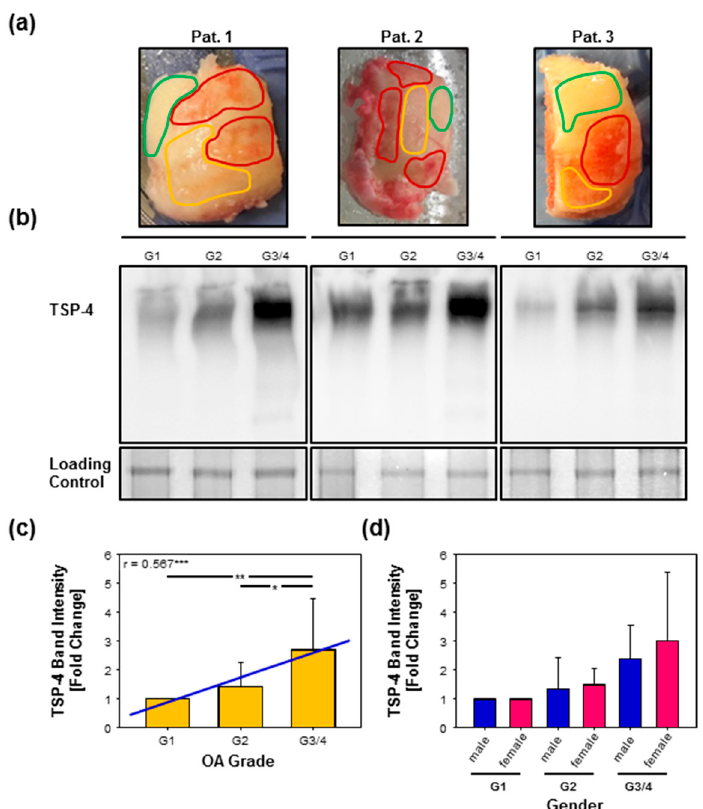
Figure 2. Detection of TSP-4 in total protein extracts from OA knee articular cartilage. ( a ) Knee condyles from three OA patients with marked areas, from which the proteins were isolated (green = grade 1 [G1], orange = grade 2 [G2], red = grade 3/4 [G3/4]). ( b ) Proteins extracted from areas of different OA severity grades were analyzed via immunoblot to detect TSP-4. Equal loading was demonstrated via PageBlue TM staining (loading control). ( c ) Statistical analysis of the immunoblots revealed an increase of TSP-4 with OA severity grade. The amount of TSP-4 correlated positively with OA severity (r = 0.567, ***, blue line). ( d ) No difference in TSP-4 levels between male and female OA patients was found at any severity grade. Immunoblots were shown as representative data from different donors. Values are represented as means ± SD and significance ( p < 0.05 *; p ≤ 0.01 **; p < 0.001 ***) was analyzed by Friedman test with Tukey post hoc analysis or Mann–Whitney U test as